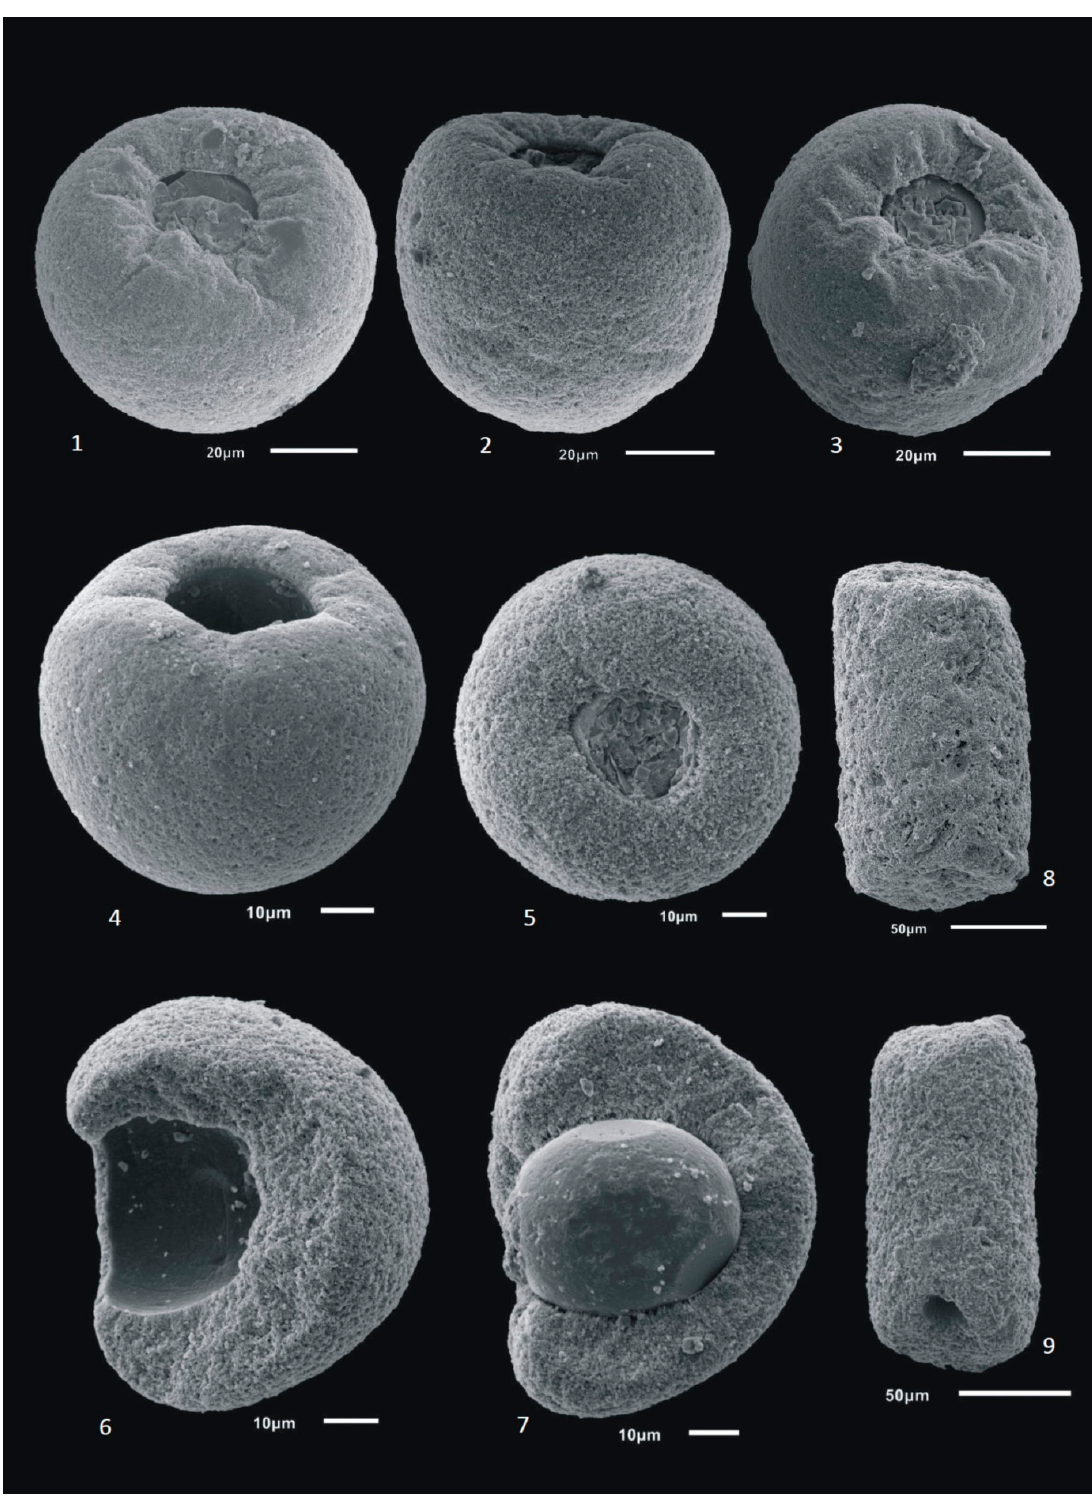
Figure 6. Algae cysts identified in the gypsum sample: (1–7). Cysts of Halicoryne morelleti (Pokorny); (8, 9)—possible algae fragments.